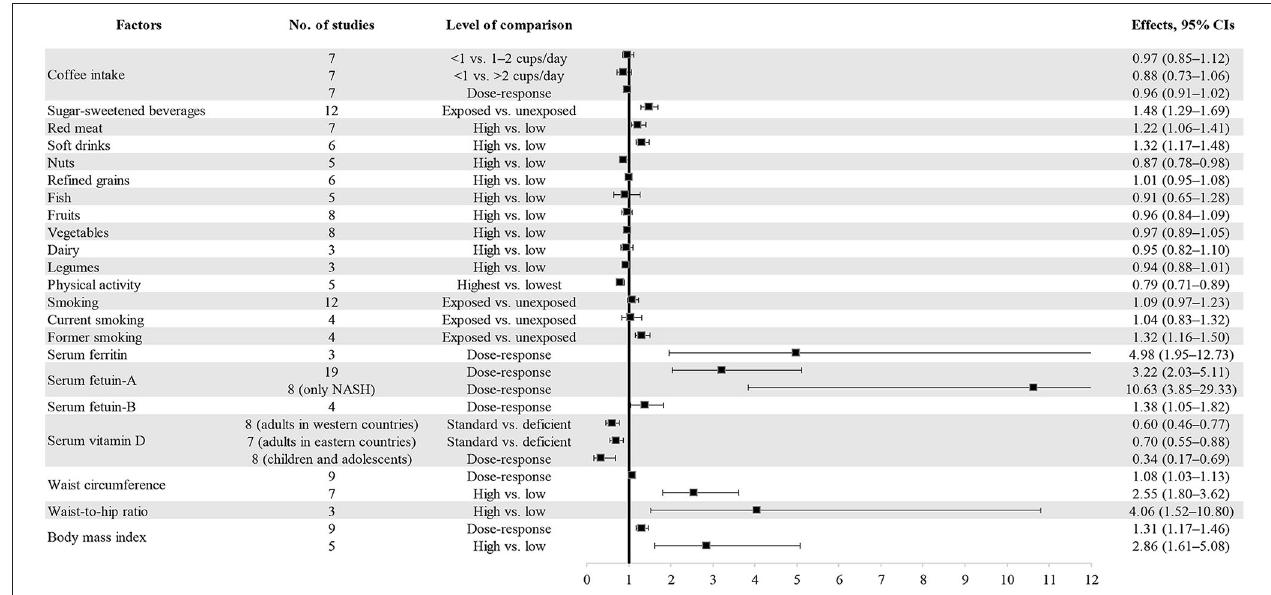
FIGURE 3 | Forest plot of summary effect sizes of multiple risk factors for NAFLD with random-effects